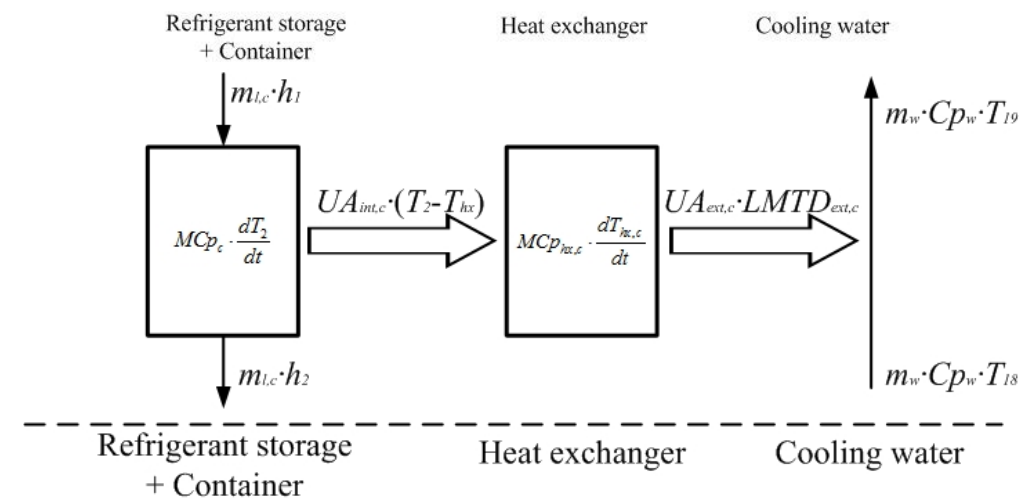
Figure 3. The energy flow diagram in the condenser.